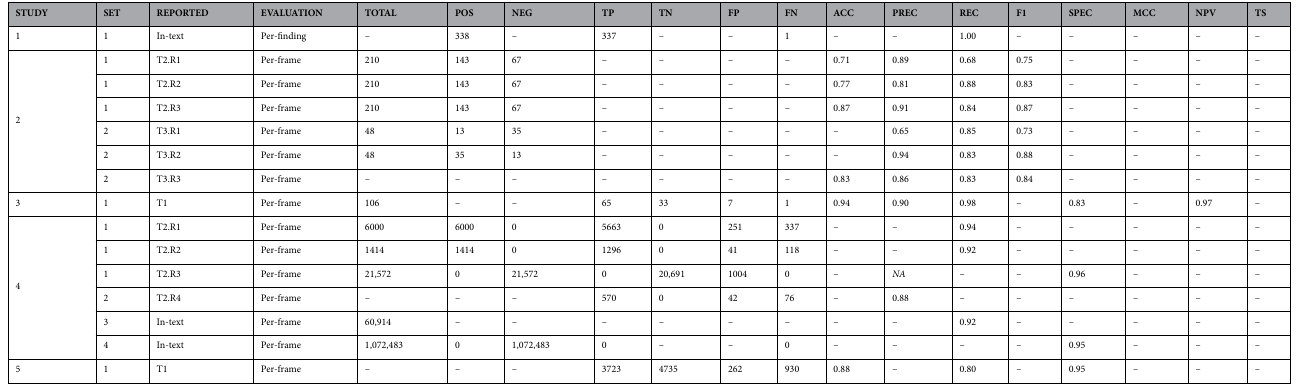
Table 1. The reported metrics of the selected studies. The STUDY column represents each of the five studies selected for metric recalculation. The SET column is the different metrics calculated for the same set of data. The REPORTED column is how the metrics were reported in the respective study. To refer to the tables in each respective paper, we use T to refer to the table number and R for the row number. The EVALUATION column is the method used to generate the metrics. The TOTAL column is the total number of samples used in the metrics calculations. The POS and NEG columns represent the total number of positive and negative samples, respectively. The remaining columns correspond the aforementioned metric acronyms described in the main